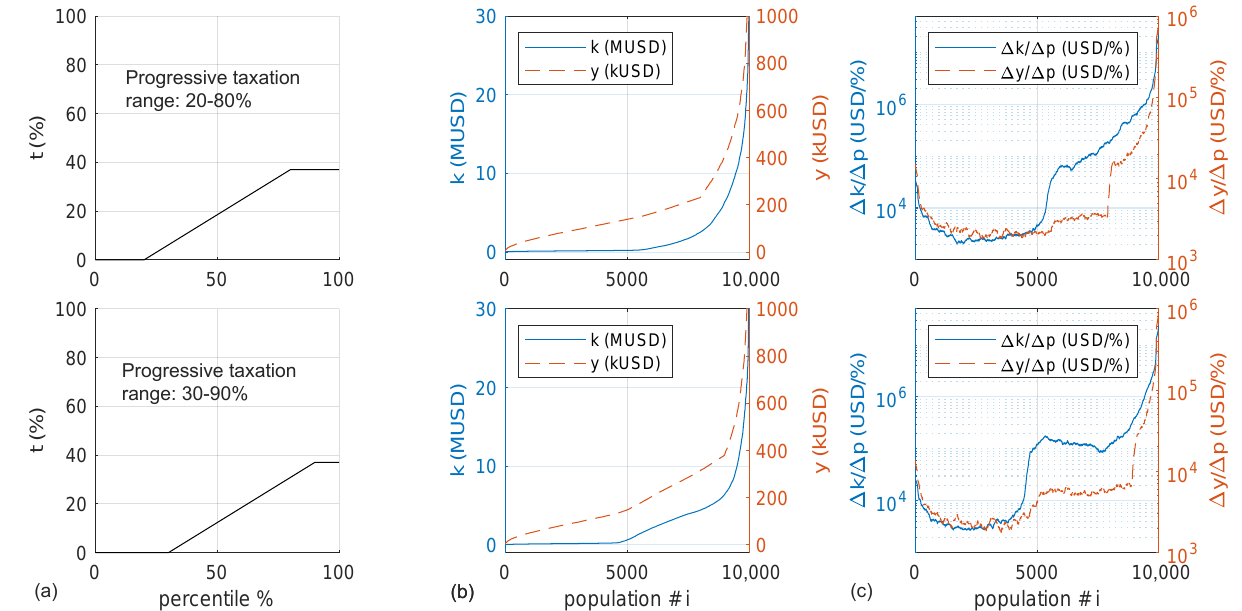
Figure 6. From top to bottom: Progressive taxation range: percentiles 20–80 and 30–90. From left to right: ( a ) Differentiation of the tax rate with respect to wealth percentile. ( b ) Distribution of capital and income in a 1 × 10 5 population after 73 years with Keynesian tax policy. ( c ) Differentiation of the wealth with respect to wealth percentile smoothed with a mean window of size